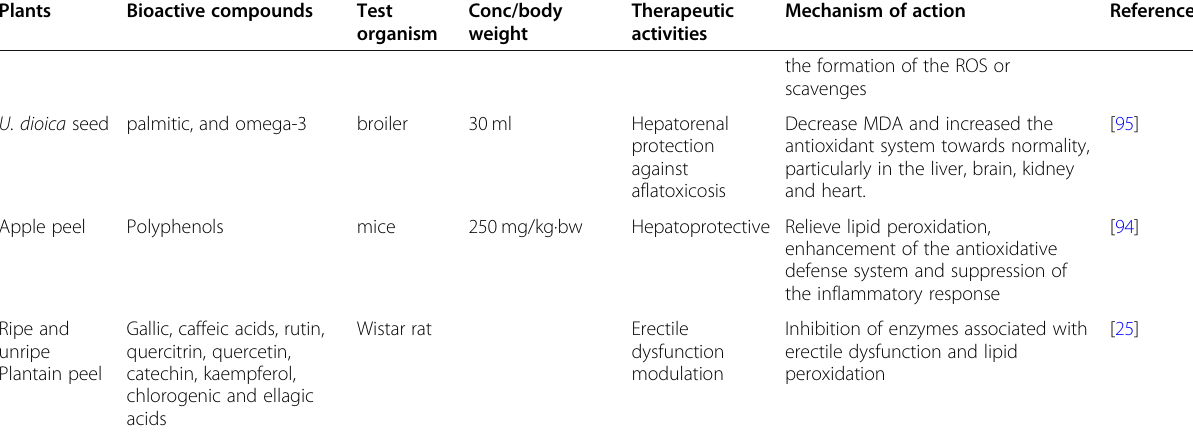
Table 5 Hepatorenal protection properties of some peels and seed extracts (Continued)